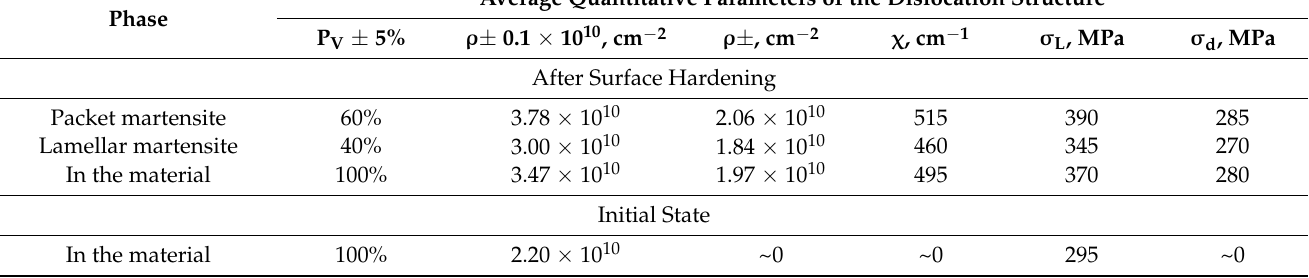
Table 5. Quantitative characteristics of the dislocation structure of the morphological components of the α -phase of 0.34Cr-1Ni-Mo-Fe steel after